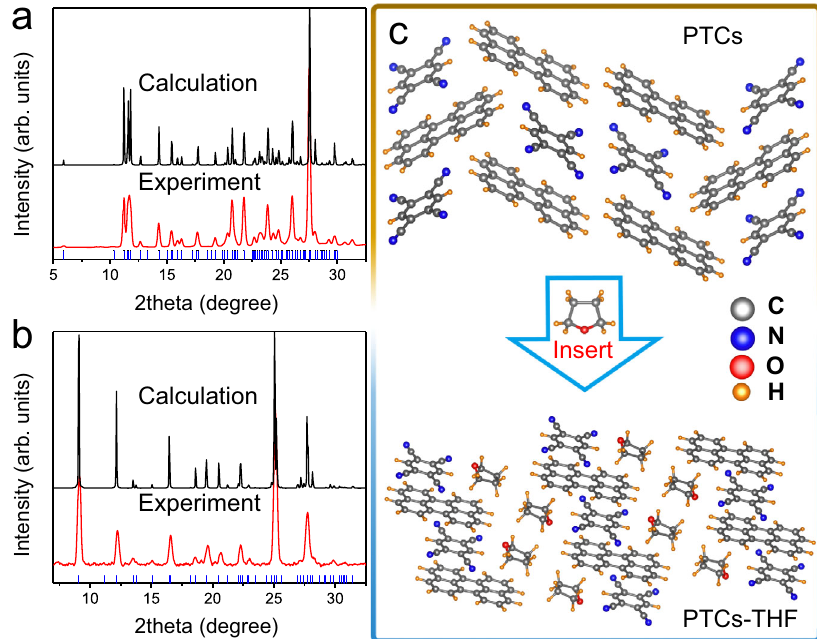
Fig. 1 XRD patterns and crystal packing of PTCs and PTCs – THF. Experimental and calculated XRD patterns of a PTCs and b PTCs – THF. c Molecular conformation and crystal packing of PTCs and PTCs – THF at ambient conditions.